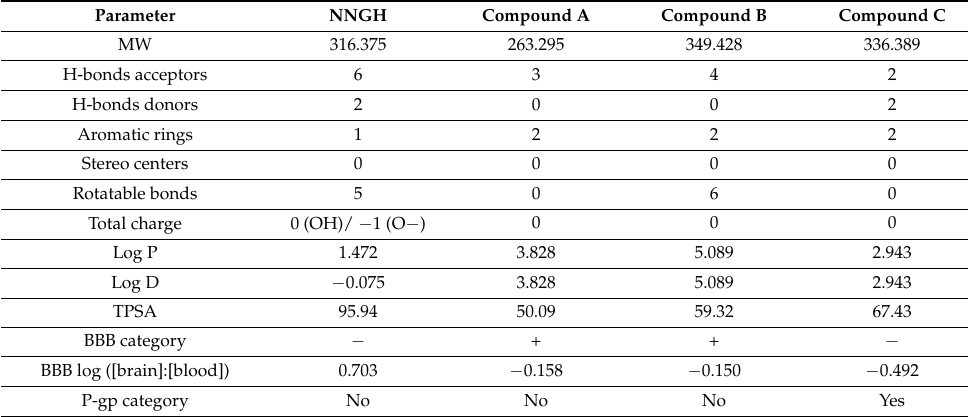
Table A1. Physicochemical and ADMET properties, by